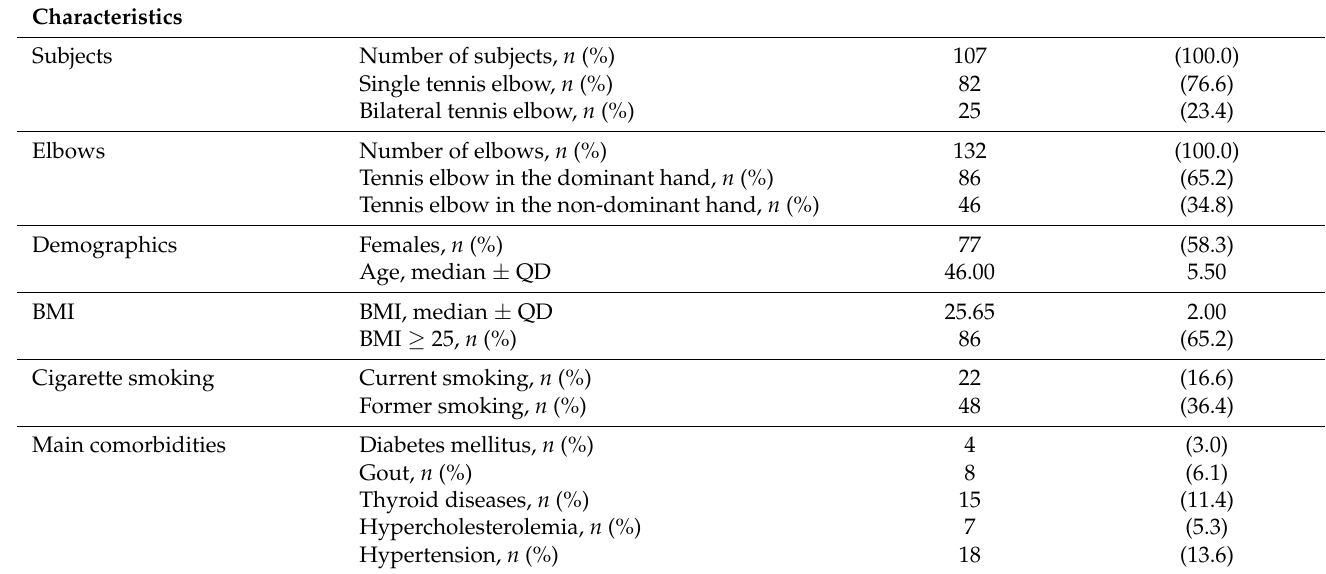
Table 1. Characteristics of the study group before the PRP injection.